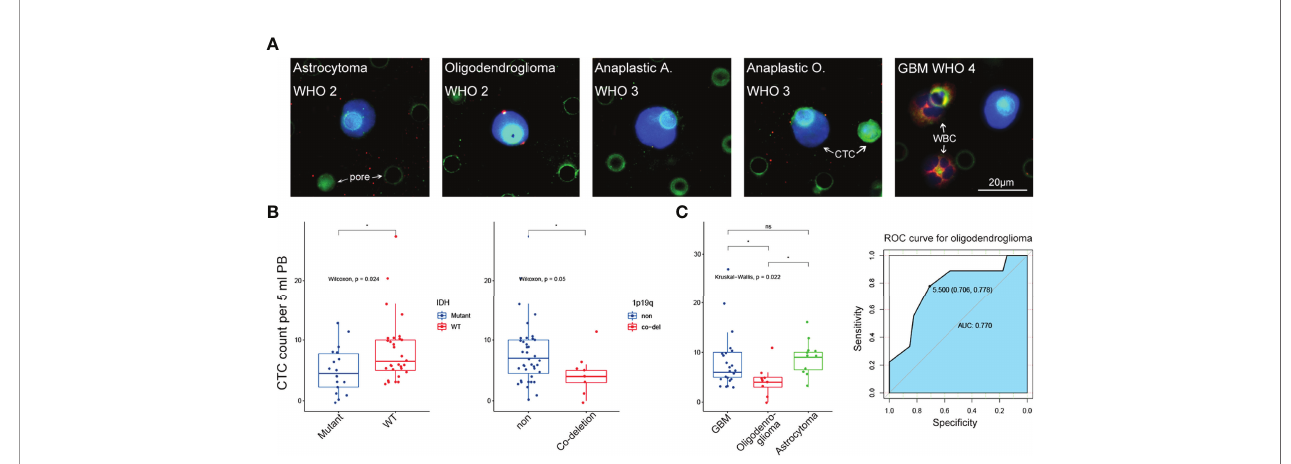
FIGURE 3 | The correlation between CTC level and clinical characteristics. (A) Representative IF image of CTC in 5 subtypes of glioma from WHO grade 2 to grade 4. Scale bar = 20 m m. (B) Left panel: low CTC level was signi fi cantly related to IDH mutant status ( p = 0.024). Right panel: low CTC level was signi fi cantly related to 1p19q co-deletion status ( p = 0.05). (C) Left panel: CTC level in oligodenroglioma was signi fi cantly lower than that in astrocytoma and GBM ( p < 0.05 and p < 0.05, respectively). Right panel: ROC curve revealed that low CTC level was a good predictor for oligodenroglioma pathological subtype (AUC = 0.770). ns, no signi fi cance.